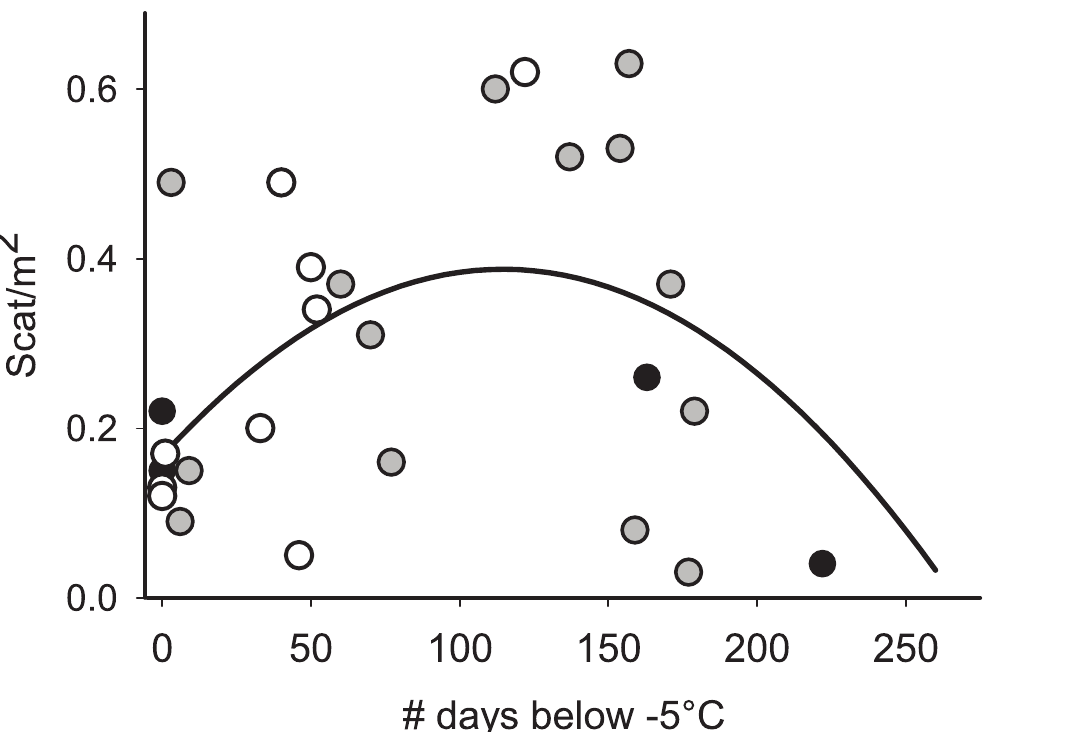
Fig 4. Relationship between American pika scat density and number of days below -5°C. Data were recorded with temperature loggers at 27 sites in the Wind River Range, Wyoming, USA from one year starting in August 2010. Colors represent different elevation ranges (white: < 3300m, (n = 9), gray: 3300-3600m, (n = 14); black: > 3600 m, (n = 4). The curve represents the predicted relationship from the top model of the temperature sensor analysis (adj. r 2 = 0.29).